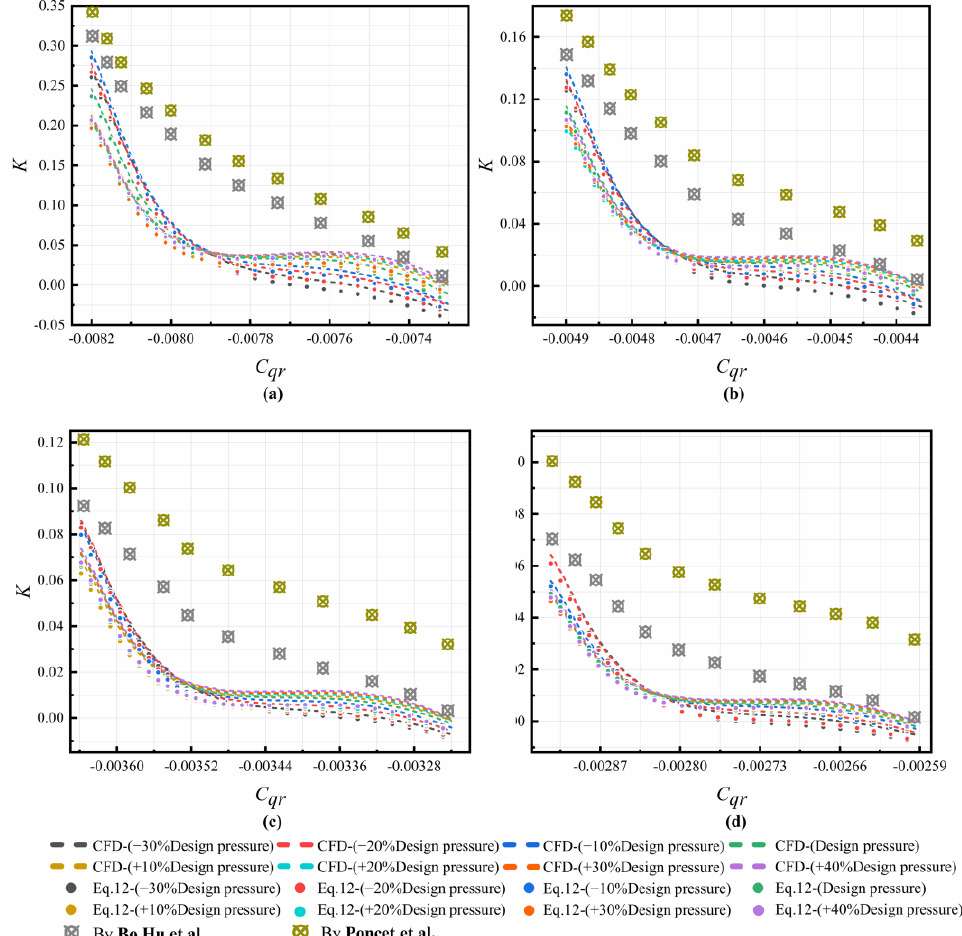
Figure 5. Comparison of core swirl ratio in C3 cavity at: ( a ) Re = 2.3793 × 10 5 , ( b ) Re = 4.7586 × 10 5 , ( c ) Re = 7.1379 × 10 5 , and ( d ) Re = 9.5172 × 10 5 [38 – 41].